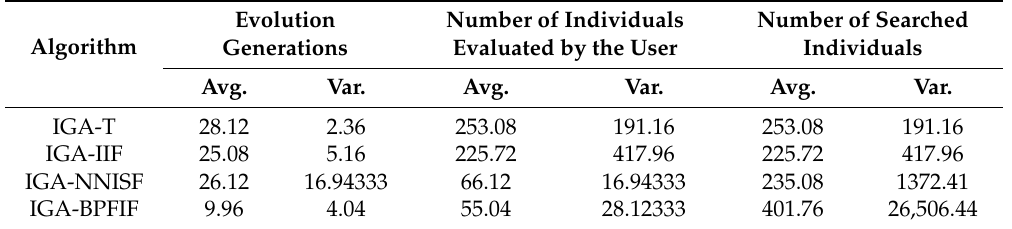
Table 4. Algorithm performance comparison.